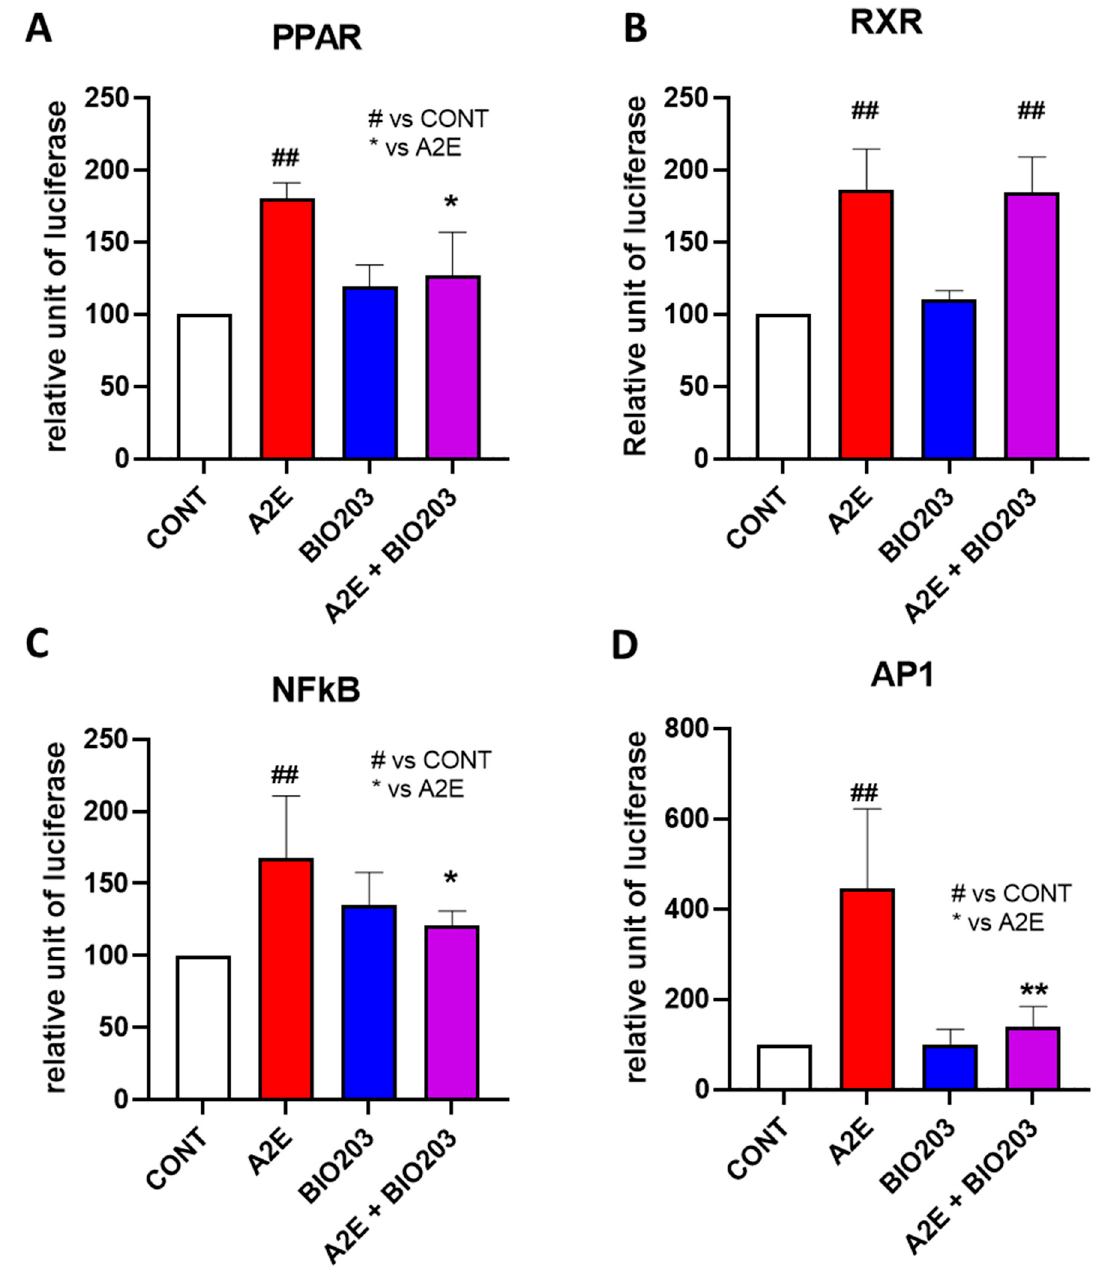
Figure 3. Effect of BIO203 at 20 µ M on PPARs, RXR, NF-KB, and AP-1 transactivation induced by A2E at 20 µ M in RPE cells in vitro. Bars represent mean ± s.e.m. with n = 3–4 per group. # or * p < 0.05, ## or ** p < 0.01, compared to CONT (One-way ANOVA, Dunnett’s post-test).